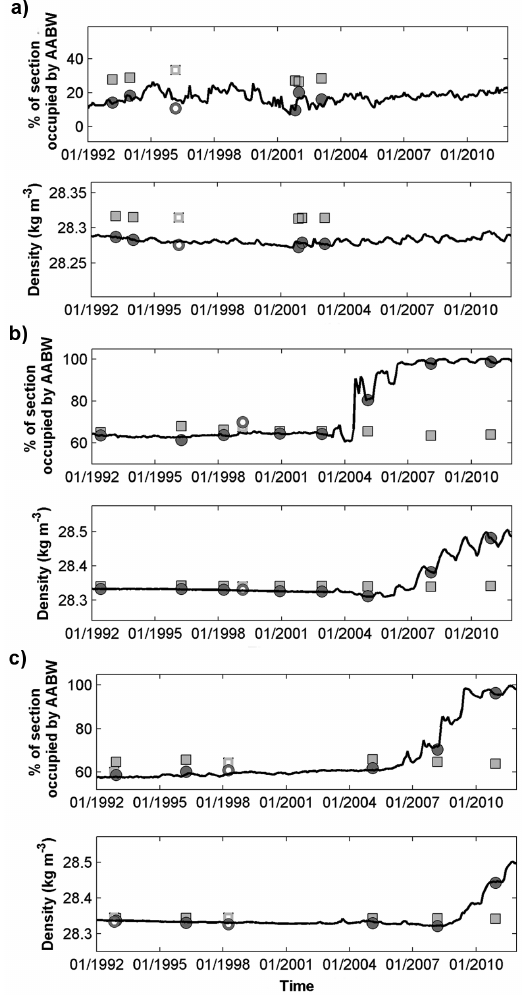
Figure 12. The percentage of the section area occupied by the AABW (upper panels) and AABW (bottom panels) layer aver- age density for the WOCE repeat sections (a) SR3, (b) SR2, and (c) SR4. Squares denote the observed estimates. The reanalysis esti- mates restricted to available observations are represented by circles. Open markers denote incomplete section occupation. Black lines re- fer to estimates based on the complete spatial and temporal ECCO2